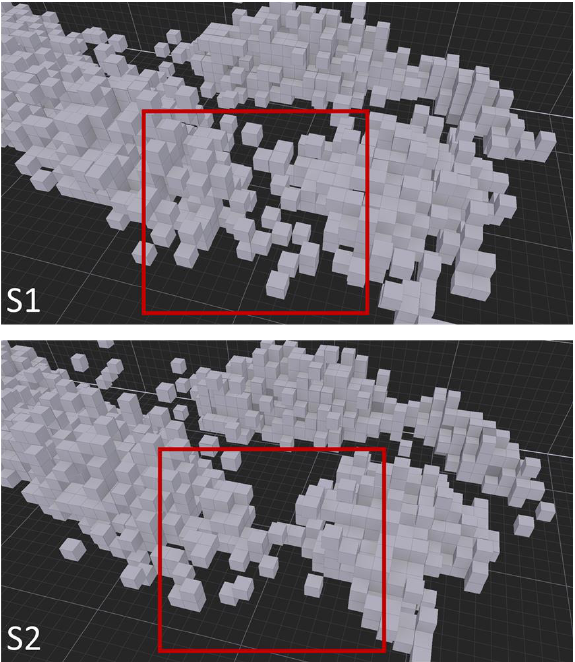
Figure 4 . Randomly distributed smoke voxels highlighted in red from ABM outputs for simulation S1 and S2